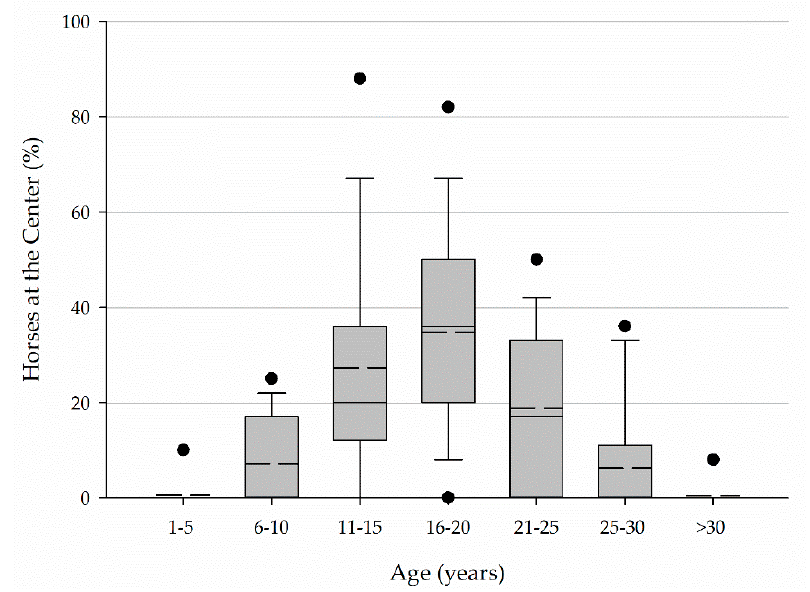
Figure 1. Age of horses at Florida PATH Intl centers. Horses remained, on average, active in a center’s program for anywhere from 1–5 years ( n = 3) to over 30 years ( n = 1) with the greatest number of centers having horses active for 6–10 years ( n = 8) (Figure 2).